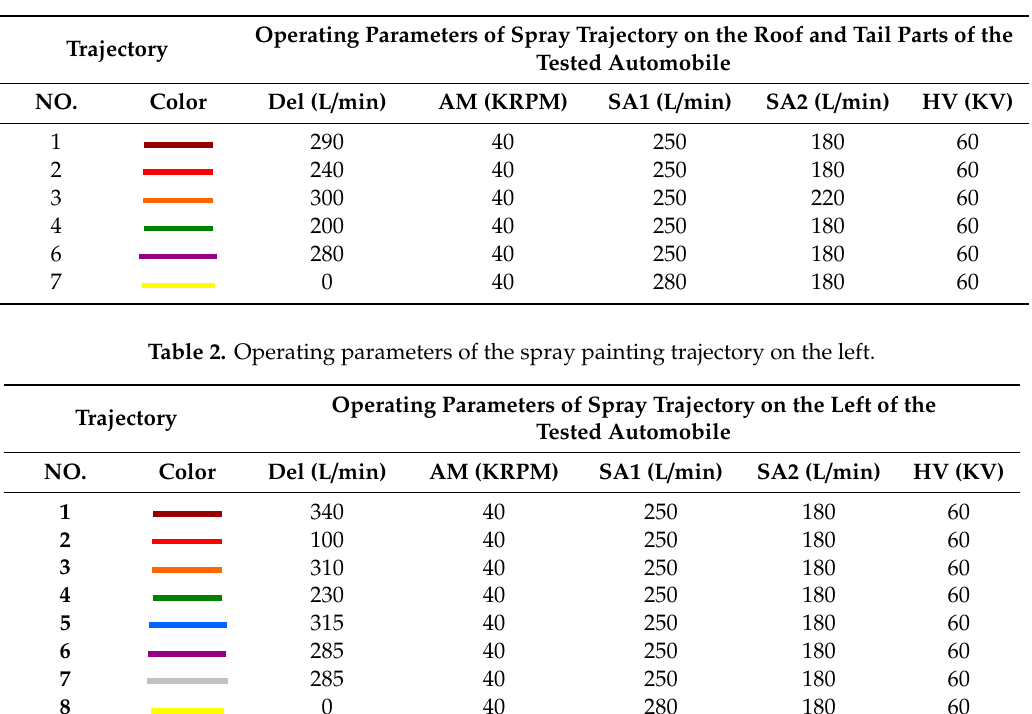
Table 2. Operating parameters of the spray painting trajectory on the left. Table 1. Operating parameters of the spray painting trajectory on the roof and tail.